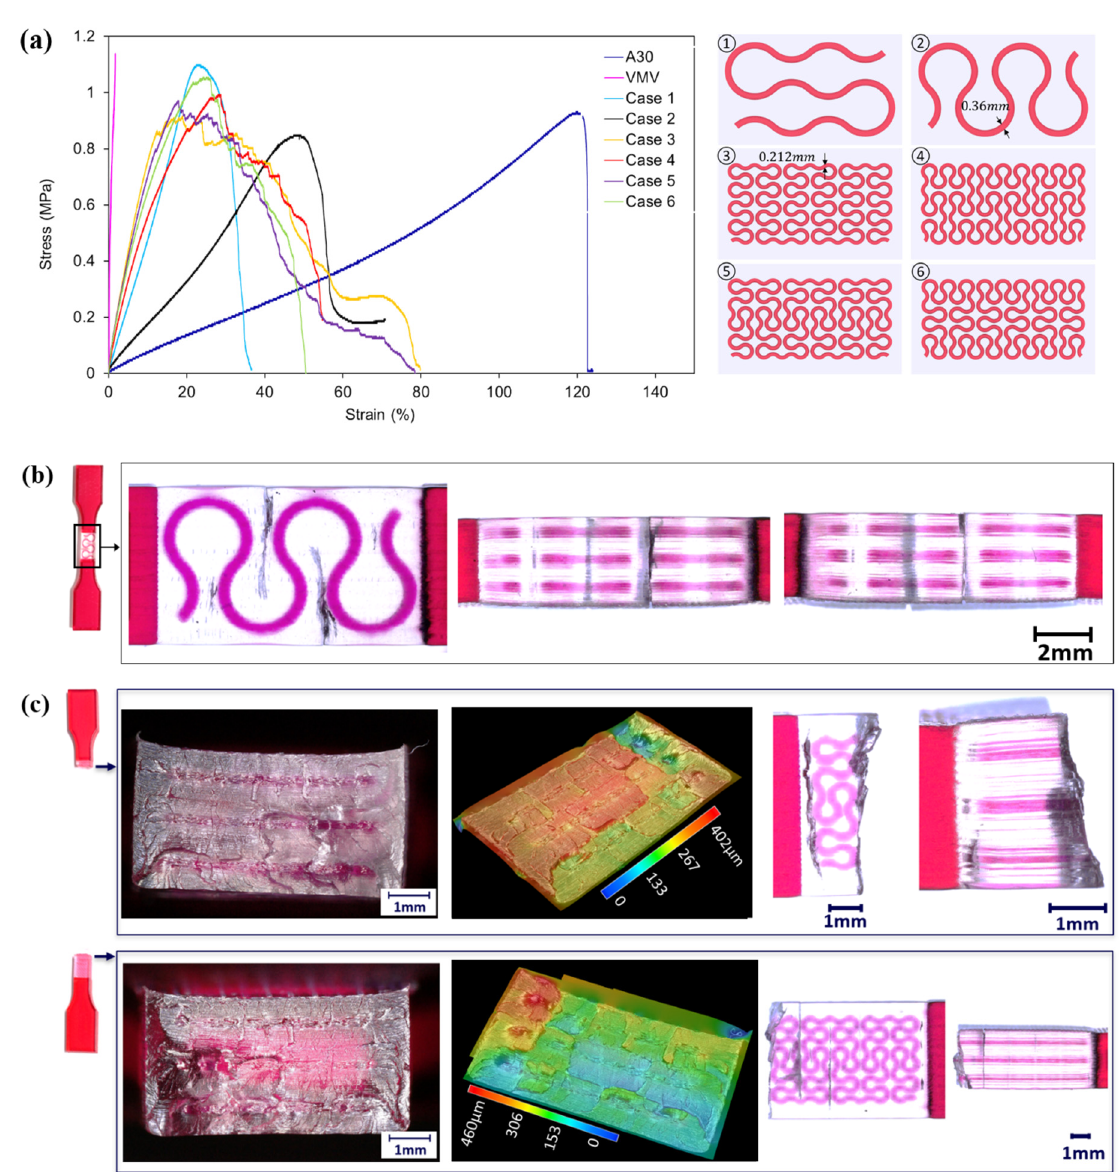
Figure 11. ( a ) Comparisons of tensile stress-strain curves of homogenous A30 (Agilus30), VMV (VeroMagentaV), and six hybrid designs (plan views of gauge sections for different hybrid cases are shown on the right); ( b ) microscopic images (50 × magnification) taken from the top and side views of the case 2 specimen, showing the cracks happening in A30 stopping near VMV reinforcement; ( c ) microscope images (50 × magnification) taken from fracture surfaces, top and side views of case 5 specimen, showing the uneven fracture surfaces, crack initiating points, and crack